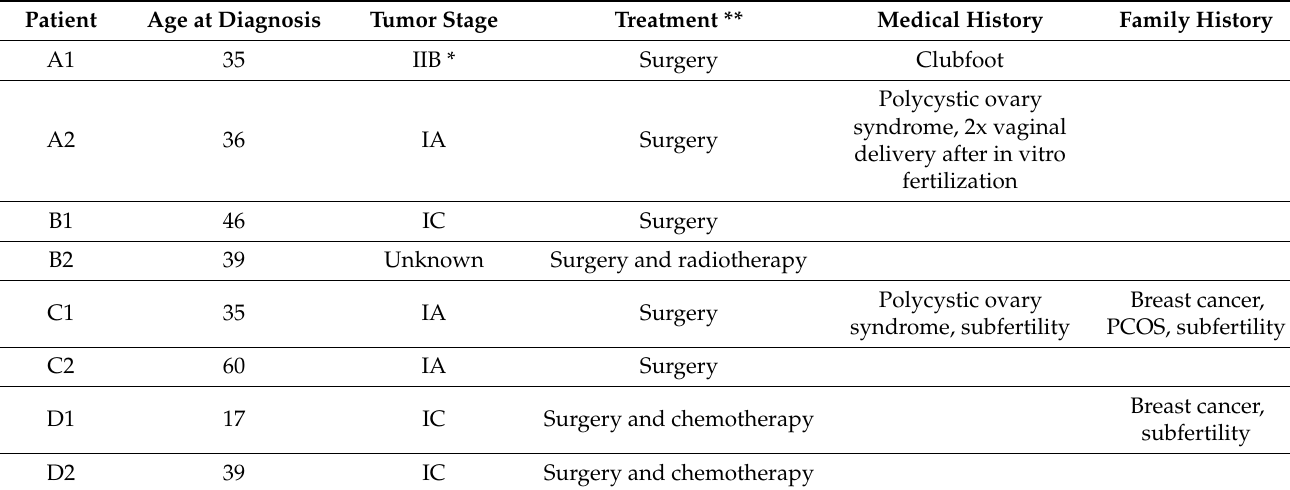
Table 1. Patient characteristics.